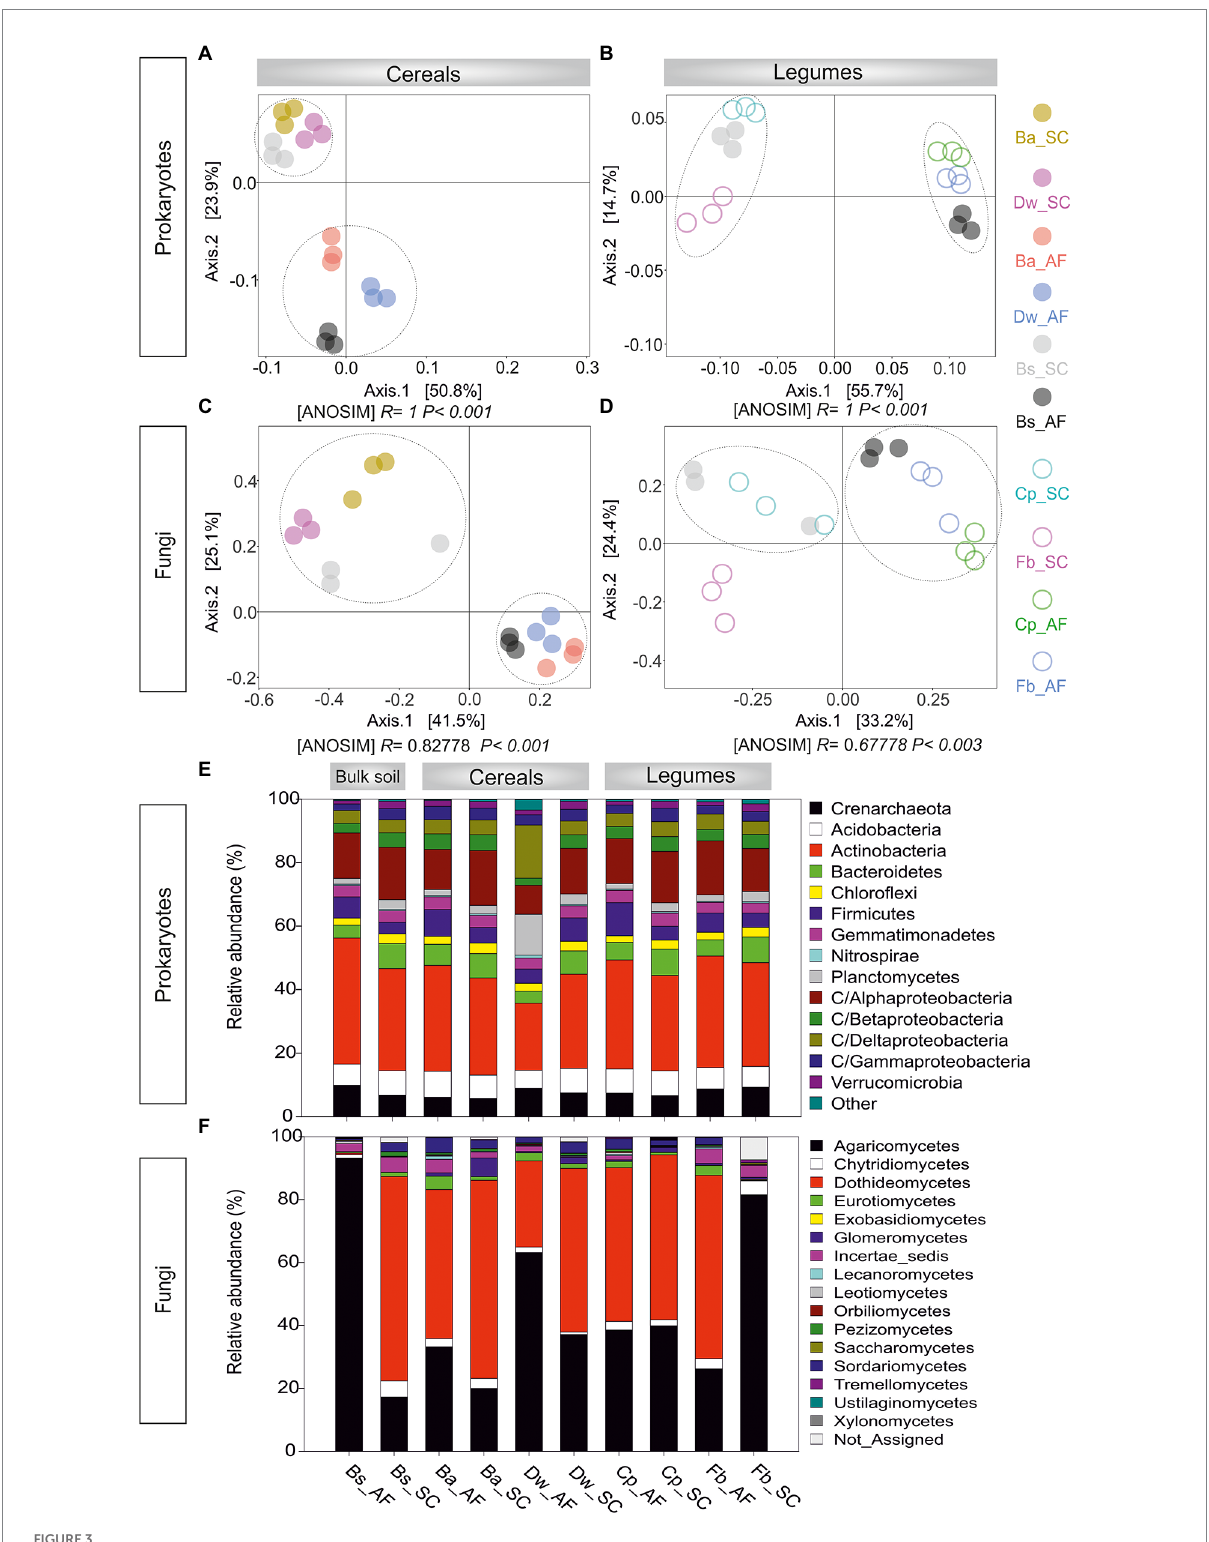
FIGURE 3 Principal coordinates analysis (PCoA) plot for the (A) procaryotic and (B) fungal communities associated with the rhizosphere of cereals and legumes. (C) Relative abundance of procaryotic and (D) fungal rhizosphere communities across the different crops. AF, agroforestry system; SC, full sun cropping; Bs, bulk soil; Ba, barley; Dw, durum wheat; Cp, chickpea; Fb, Faba bean. The relative abundance of each phylum, class, and order in different rhizosphere samples was summarized in histogram graphs using R software environment (v.3.2.5) and the significant differences were determined using Tukey’s HSD statistical